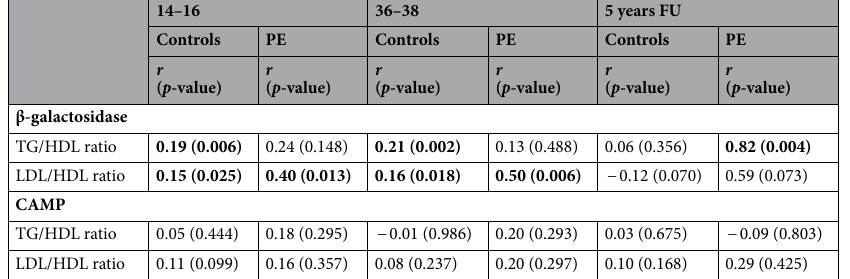
Table 2. Associations between β-galactosidase, CAMP and lipids. Significant associations in bold.